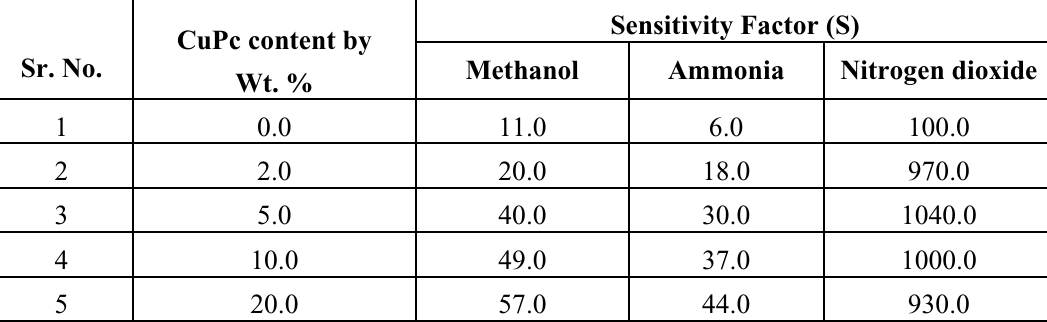
Table 1. Sensitivity of PANI-CuPc polymers with chemical vapours.